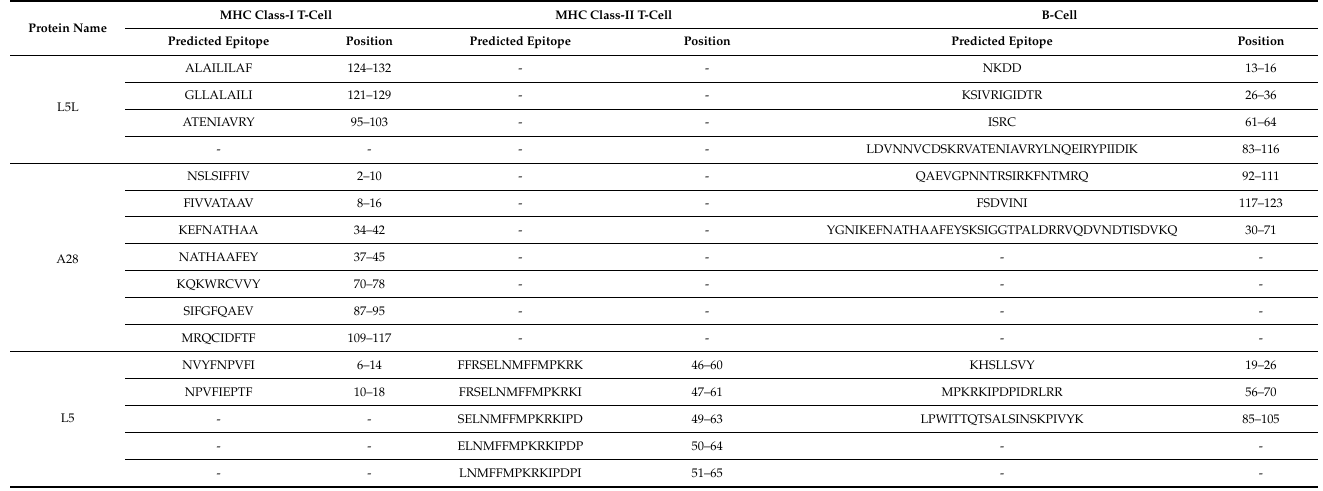
Table 4. Combined results of MHC class-I T-cell, MHC class-II T-cell and B cell epitope prediction in three filtered proteins.